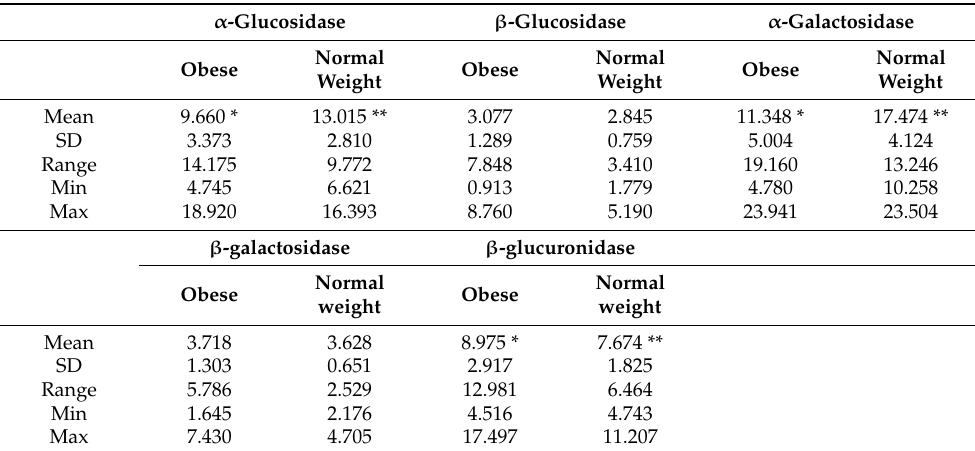
Table 4. Comparison of the activity of fecal enzymes in the group of obese children versus the group of children of normal weight. α -Glucosidase β -Glucosidase